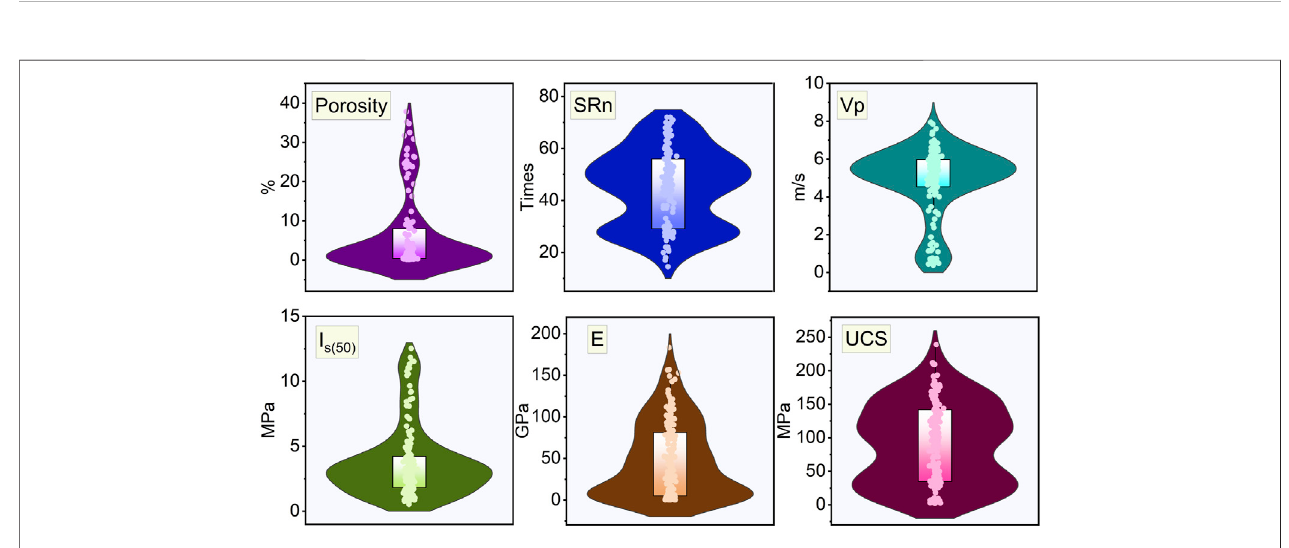
FIGURE 6 | Data violin